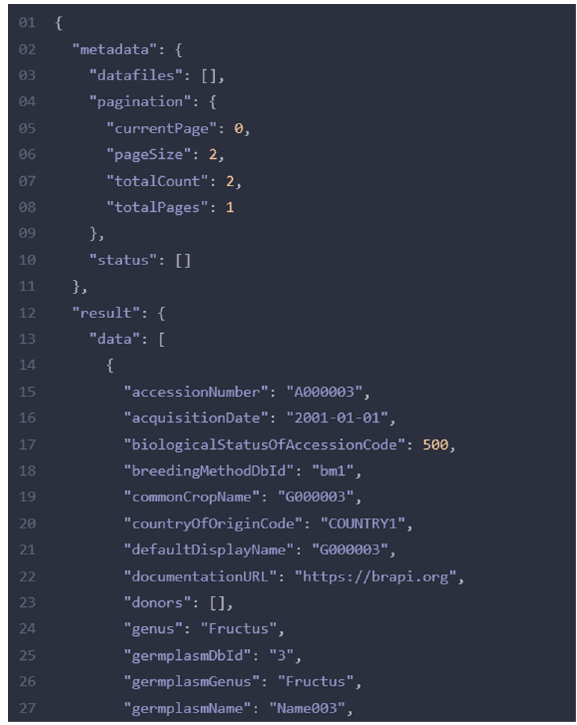
Figure 5: Example JSON output for the BrAPI call GET /germplasm-search – the first element comprise meta data, like status, linked data files and pagination